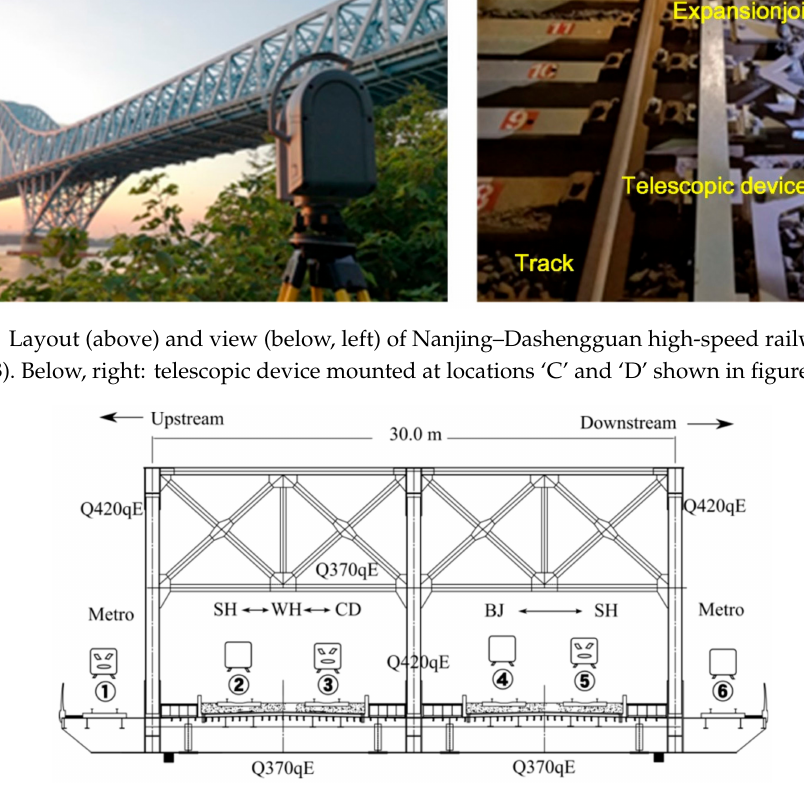
Figure 3. Cross-section of the NDHRB deck showing di ff erent uses of the tracks. 1 (cid:79) Nanjing Metro Line S3 Upstream (S3-U); 2 (cid:79) Beijing–Shanghai (BJ-SH) high-speed railway; 3 (cid:79) Shanghai–Beijing (SH–BJ) high-speed railway; 4 (cid:79) Shanghai–Wuhan–Chengdu (SH–WH–CD) high-speed railway; 5 (cid:79) Chengdu–Wuhan–Shanghai (CD–WH–SH) high-speed railway; 6 (cid:79) Nanjing Metro Line S3 downstream